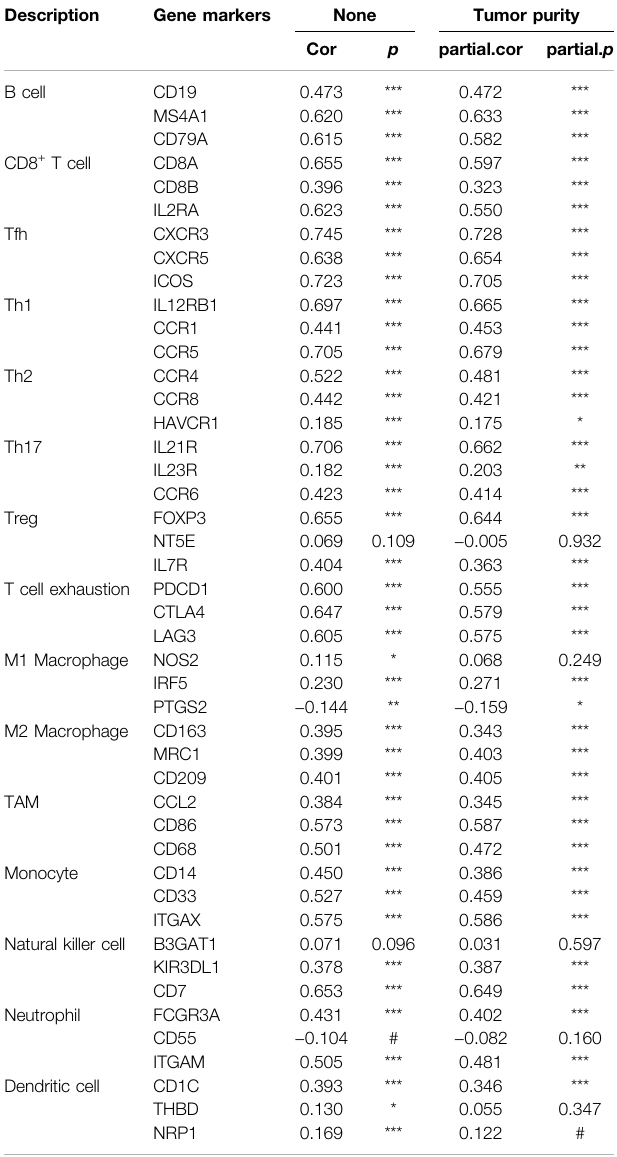
TABLE 2 | Correlation analysis between LTA and immune cell gene markers in TIMER.